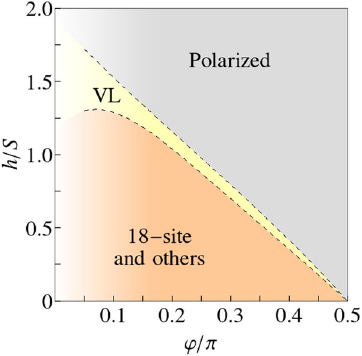
Fig. 2 Schematic phase diagram. The classical magnetic vortex liquid appears in the parametric regime between the dashed lines, right below the high- fi eld polarized state. At low and intermediate fi elds, we fi nd a relatively dominant 18-site order, as well as other ordered